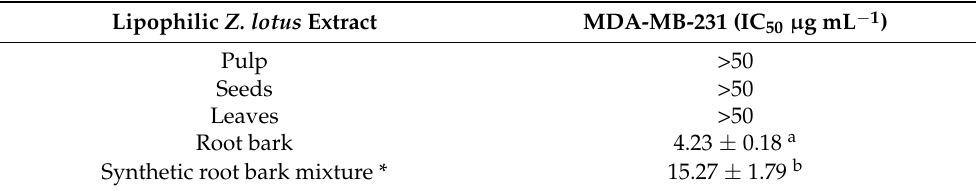
Table 2. IC50 values of lipophilic extracts of Z. lotus on TNBC cell line MDA-MB-231, obtained by using the MTT